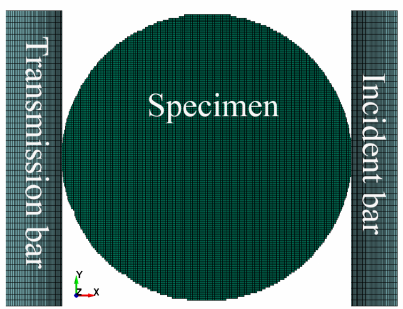
Figure 8. Numerical model of the Brazilian disc specimens.